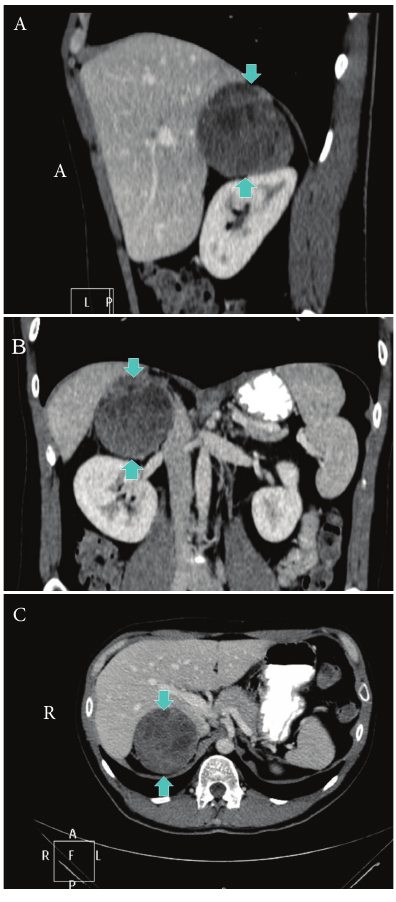
Figure 1: Computed tomography of the abdomen showing the right adrenal mass with malignant features, such as heterogeneous contrast enhancement. (A) sagittal plane, (B) coronal plane, and (C) axial plane (blue arrows point to the